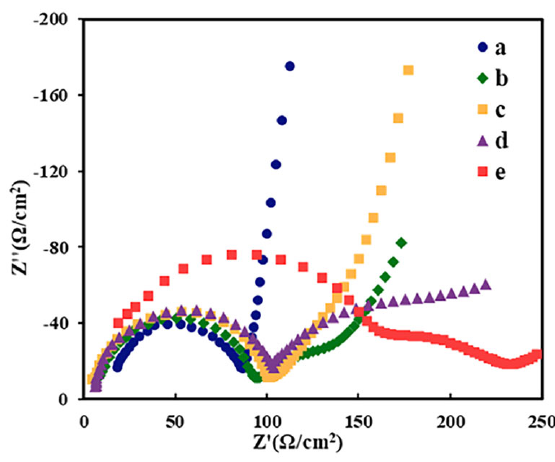
Figure 8. Electrochemical impedance spectroscopy (EIS): (a) bare GCE, (b) fMWCNTs/GCE, (c) mPEG-fMWCNTs/GCE, (d) GDH/mPEG-fMWCNTs/GCE, and (e) IL/GDH/mPEG-fMWCNTs/GCE. The experiments were performed at 0.20 V potential with the frequency ranging from 102 to 106 Hz in 0.1 M KCl solution containing 5 mM [Fe(CN) 6 ] 3 − /4 − at 25 ± 1 °C.